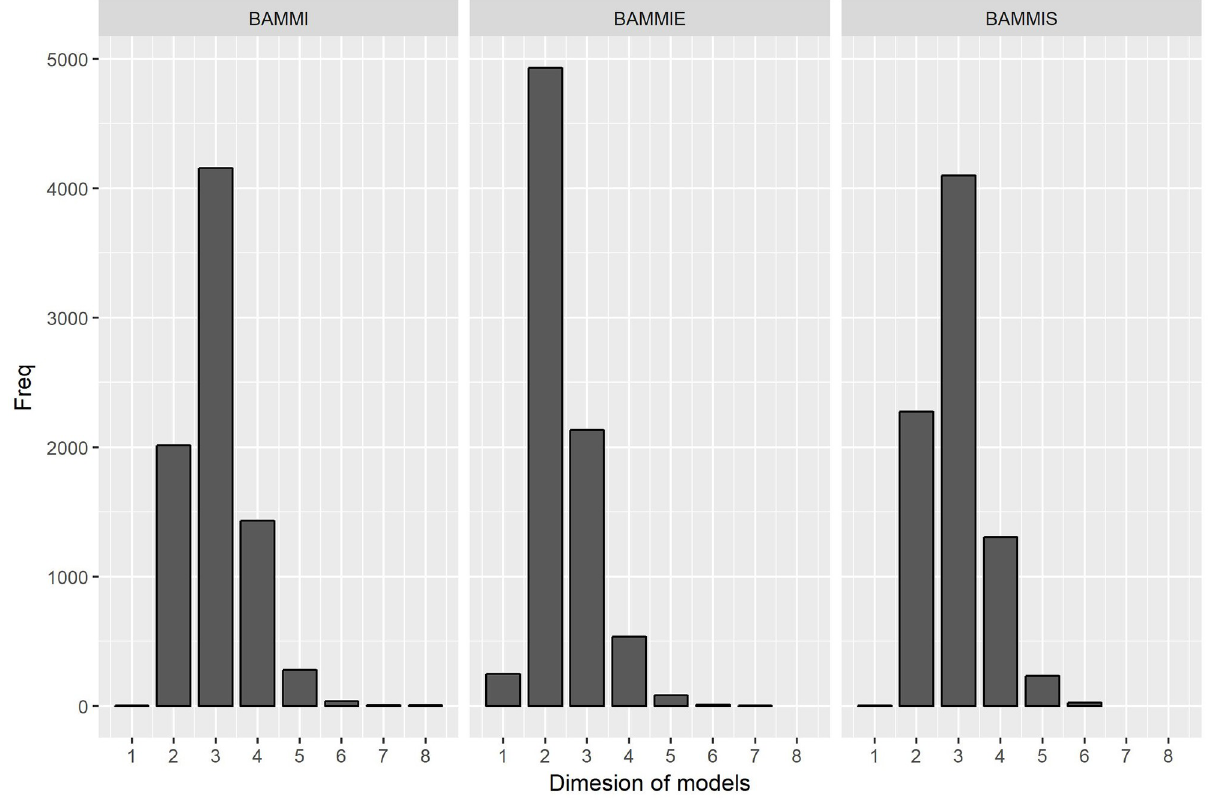
Fig 2. Frequency referring to the dimension (t) of the model accepted during the RJMCMC (simulated data).